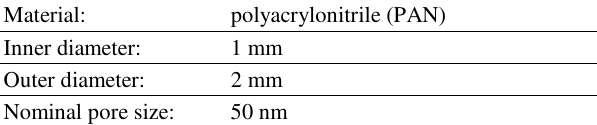
Table 1 . Specifications of hollow fiber membrane.